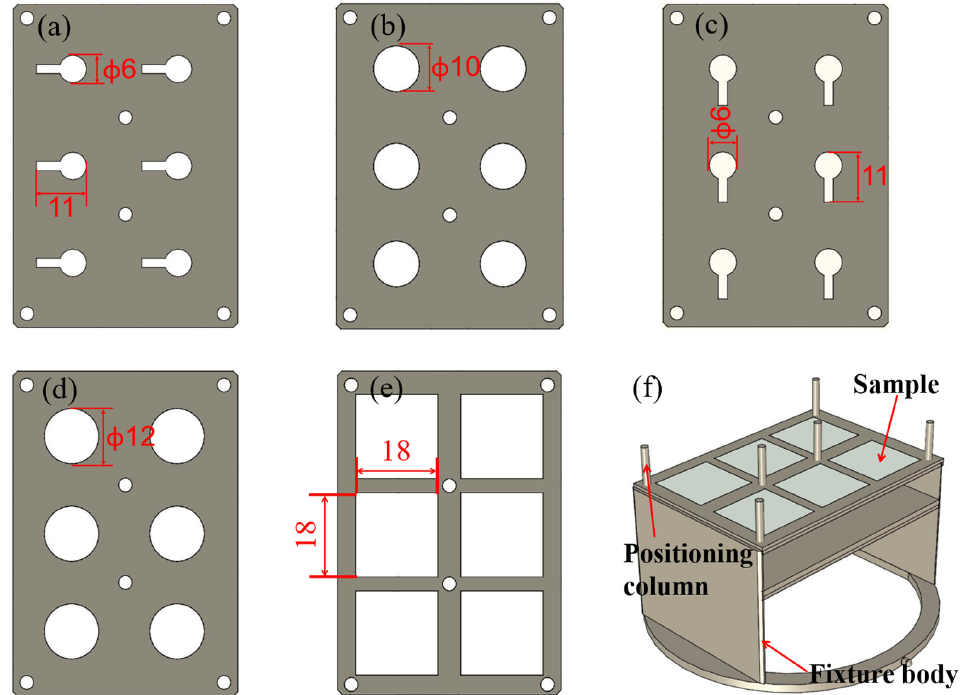
Figure 5. Stainless-steel mask plate of piezoelectric film sensor for fixture: ( a ) stainless-steel mask plate of NiCr bottom electrode; ( b ) stainless-steel mask plate of ZnO piezoelectric film; ( c ) stainless-steel mask plate of NiCr top electrode; ( d ) stainless-steel mask plate of SiO 2 protective film; ( e ) sample positioning plates; ( f ) schematic diagram of fixture.